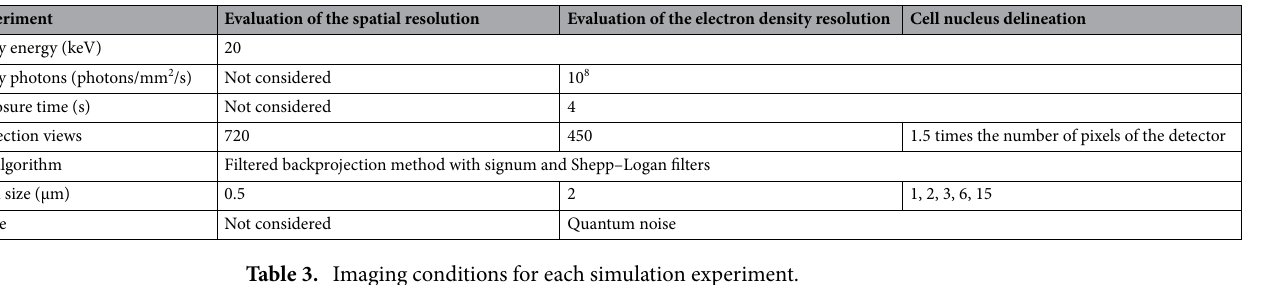
Table 3. Imaging conditions for each simulation